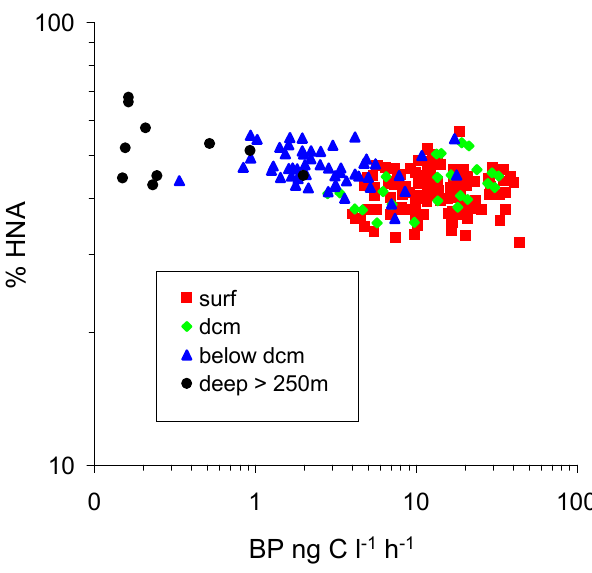
Fig. 8. Relationships between bacterial production and the percent- age of HNA